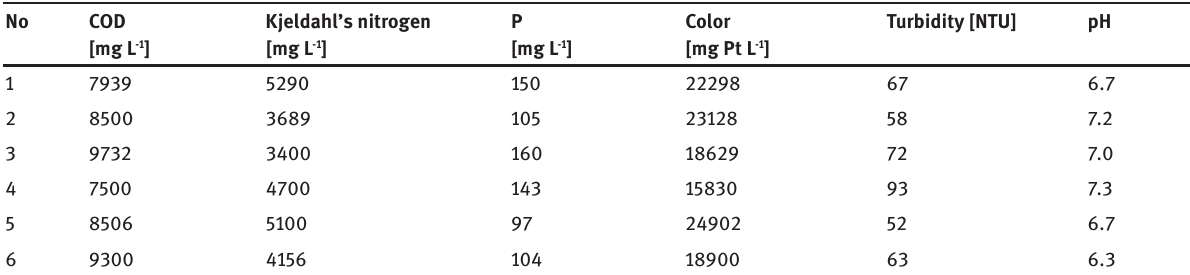
Table 2: Characteristic of wastewater from MBM